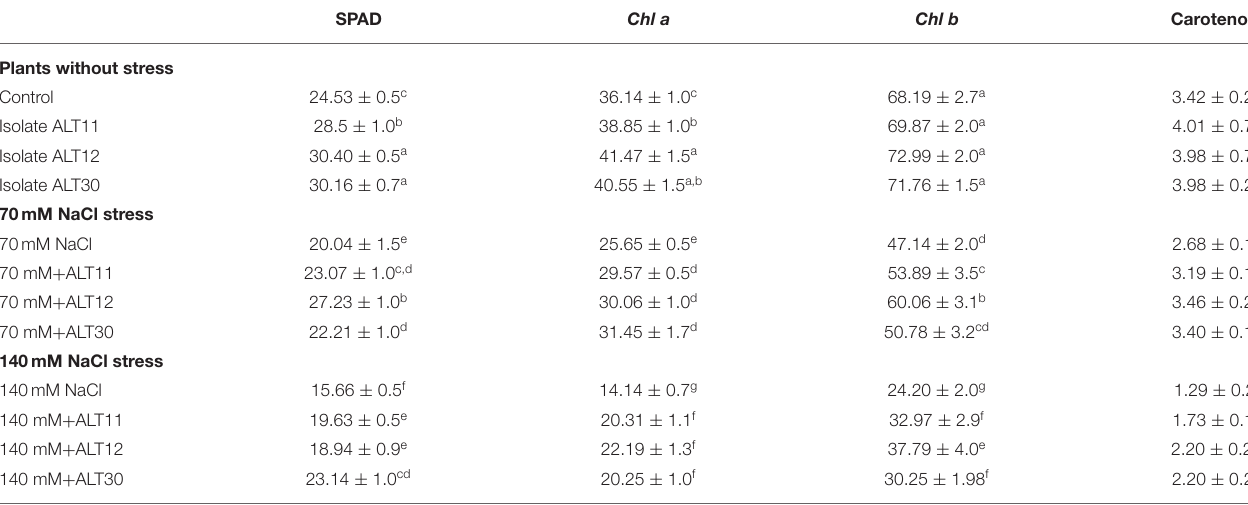
TABLE 2 | The effect of NaCl stress on different chlorophyll contents of rice with and without the inoculation of isolates ALT11, ALT12, and ALT30. SPAD Chl a Chl b Carotenoid Plants without